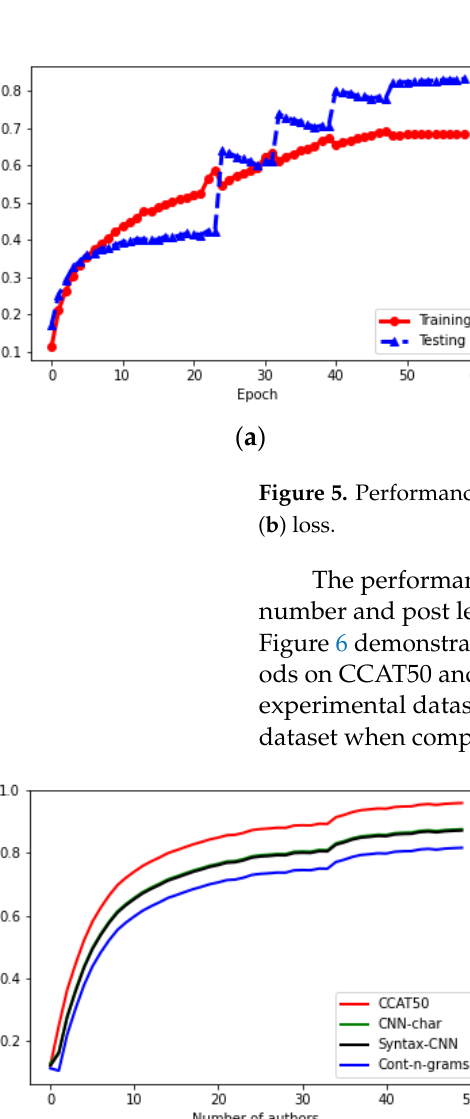
Figure 4. Performance accuracy and loss curves over epoch on the Blogs50 datasets: ( a ) accuracy,